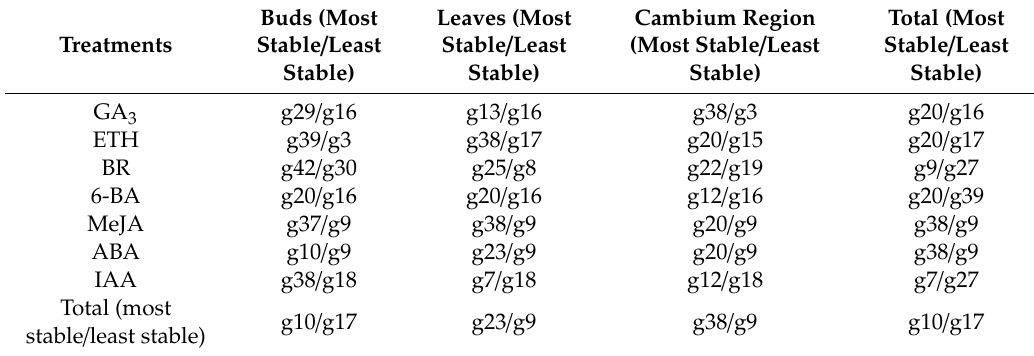
Table 2. Summary of the most and least stable internal reference genes with different treatments.